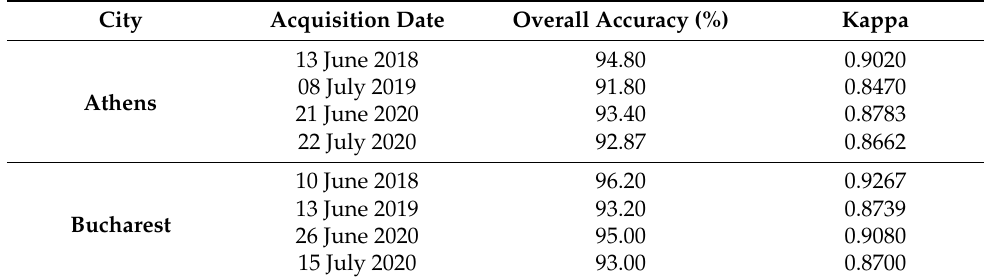
Table 2. Accuracy results for GEOBIA classification at city